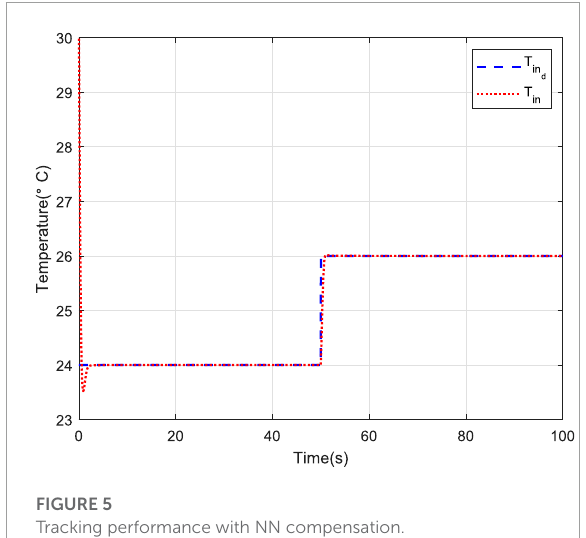
TABLE 2 Objective of the tracking step signal.